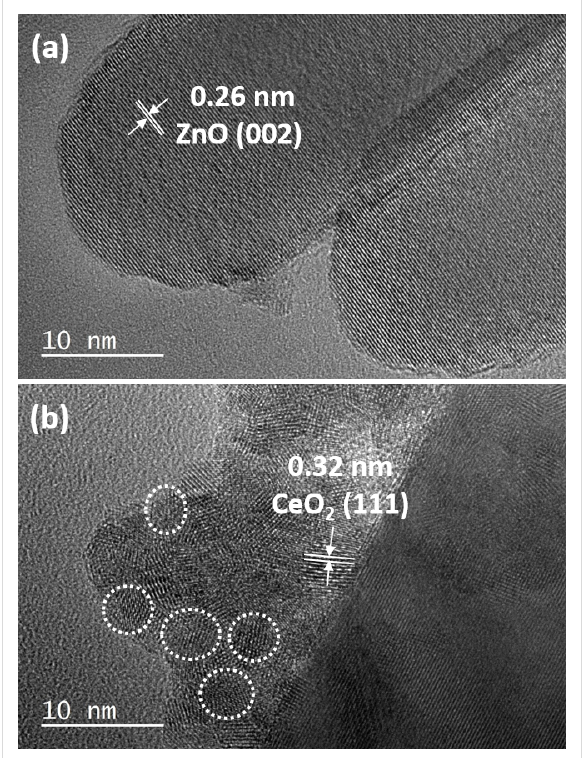
Figure 6: (a) HRTEM image of 5% Ce-doped ZnO rods, and (b) TEM image of the 10% Ce-doped ZnO rods showing CeO 2 nanoparticles at the periphery of the